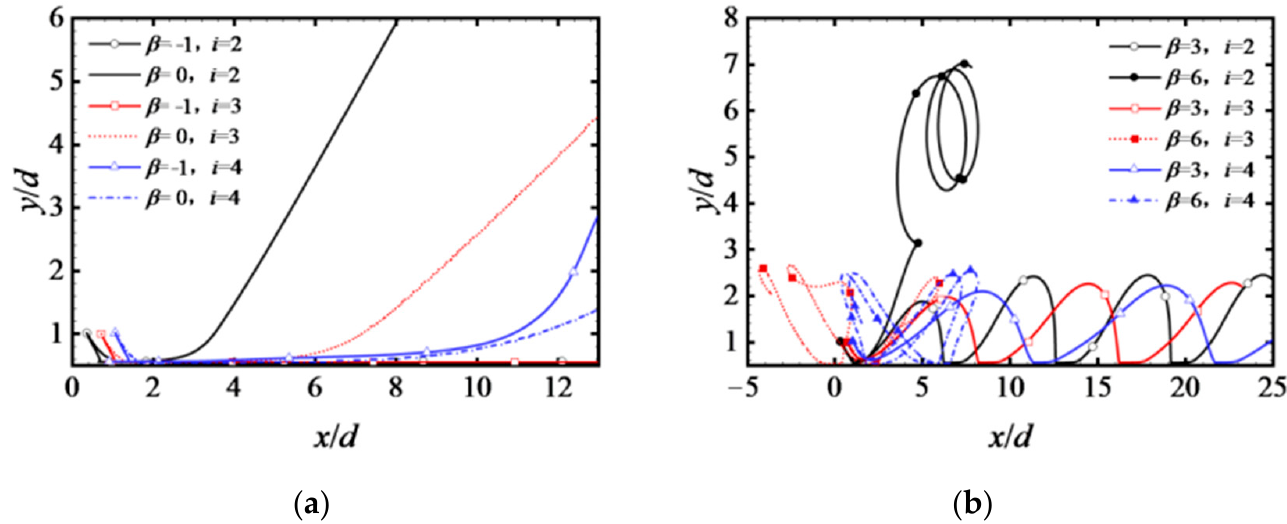
Figure 11. Trajectory of rod-shaped squirmers with different values of i ( Re s = 0.5, s = d ): ( a ) β = − 1 and β = 0; ( b ) β = 3 and β = 6.